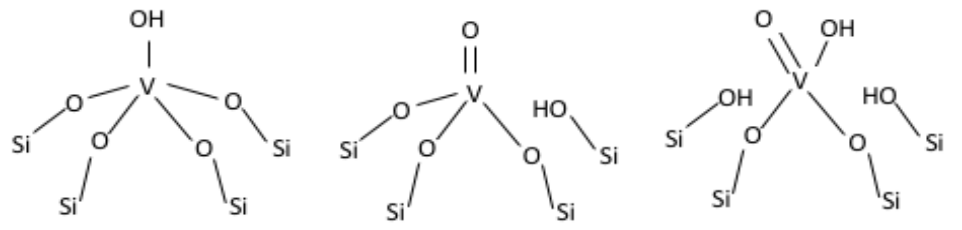
Figure 3. Different forms of vanadium species.